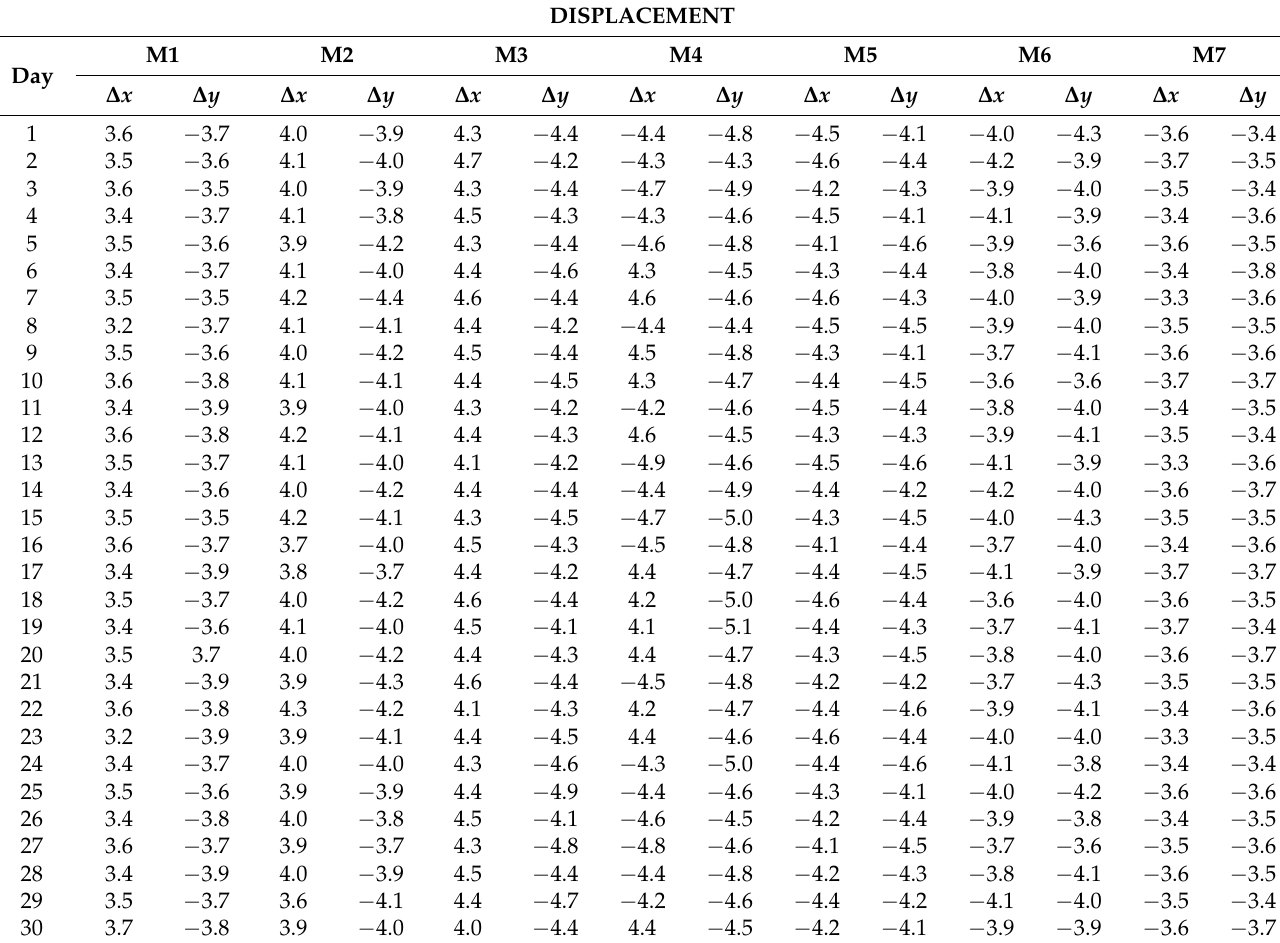
Table 7. Displacements of the markers.